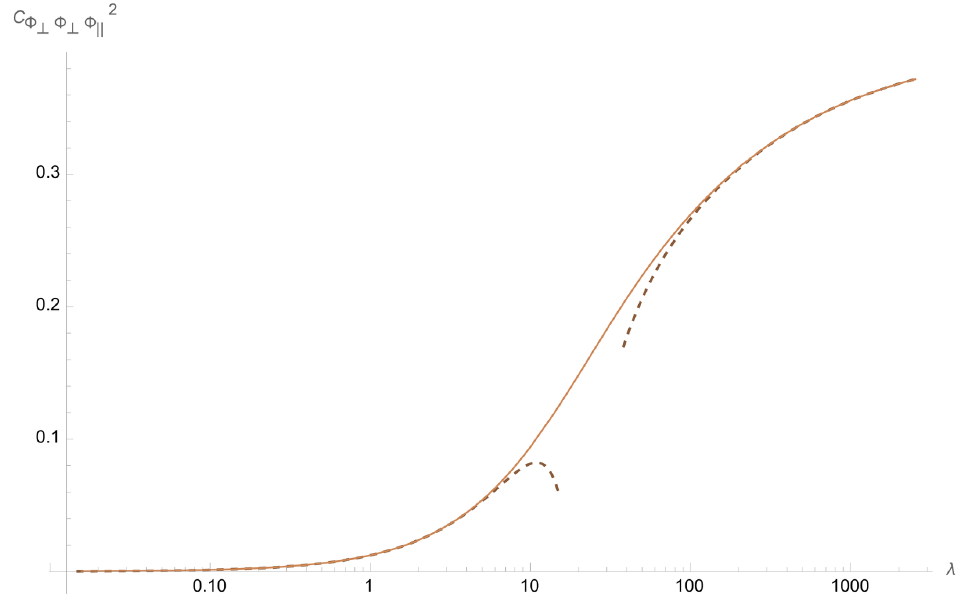
Figure 1 . High precision non-perturbative evaluation of the structure constant of two protected one non-protected operators C 2 in the defect CFT living on the Maldacena-Wilson line, Φ ⊥ Φ ⊥ Φ || as obtained by [2] (solid line). Dashed lines represent weak and strong coupling analytic results of [2, 18,